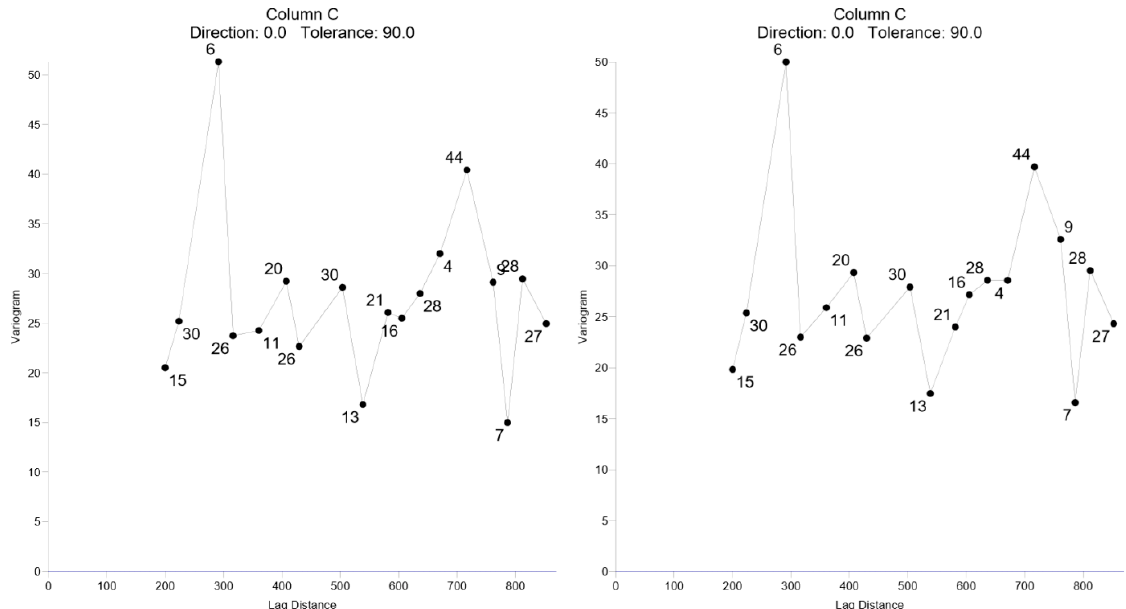
Figure 9. Semivariogram of Co abundance [kg/m 2 ] in deposit balance zone for Co (limonite horizon and transition zone—right) and in limonite horizon.